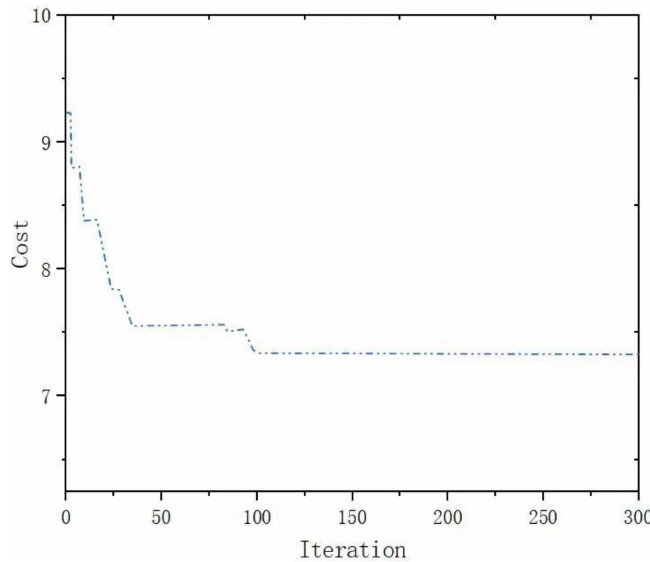
Figure 10. Cost iteration convergence graph for blank dimension